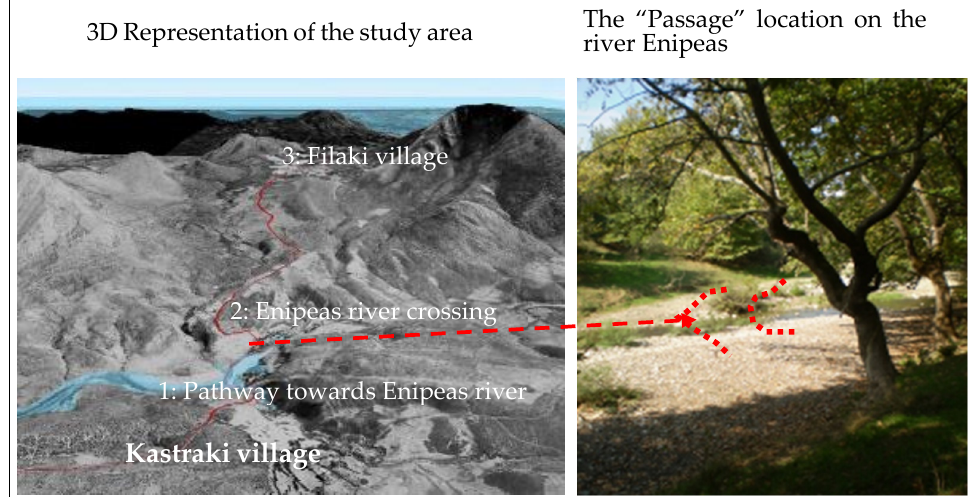
Figure 6. Validation of the “Passage” location on the river Enipeas.  The “Dervish School” monument